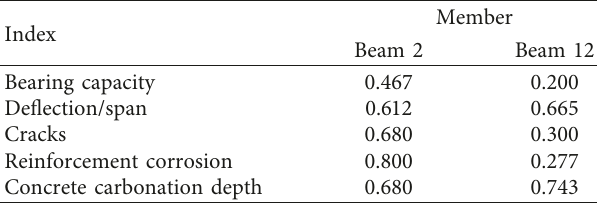
Table 8: The normalized inspection data of beams 2 and